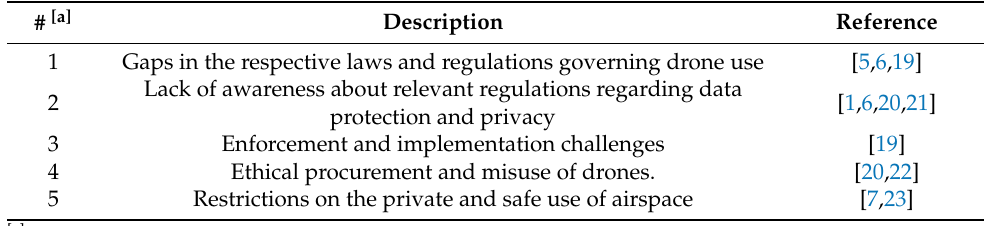
Table 4. Challenges identified from SLR.